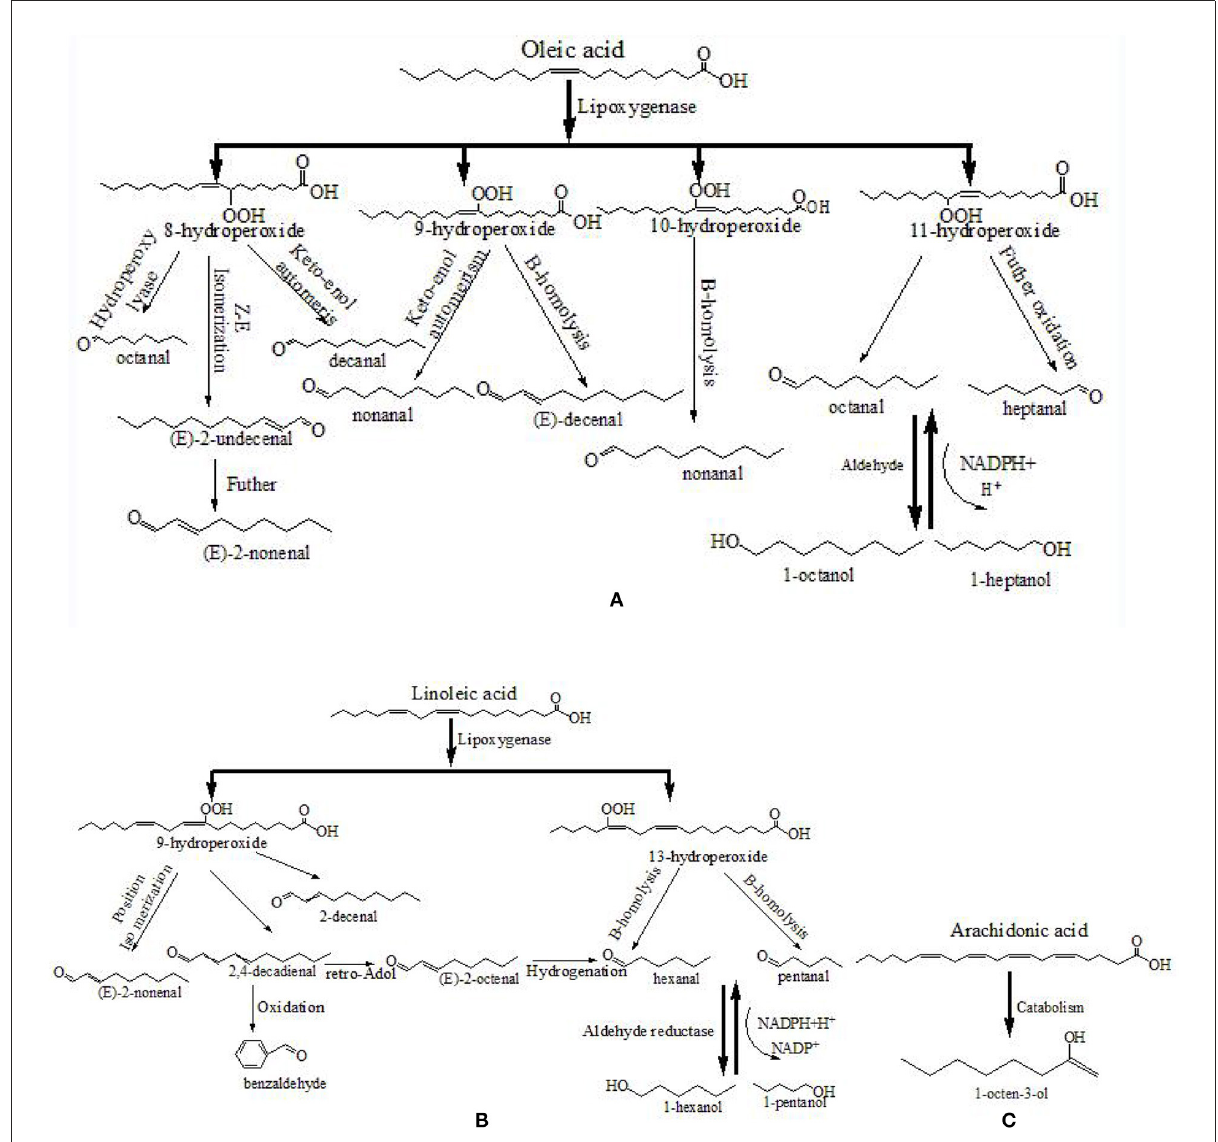
FIGURE5 Formation pathway of the typical aliphatic aldehydes from the fatty acid (A–C) . Referred to Al-Dalali et al.